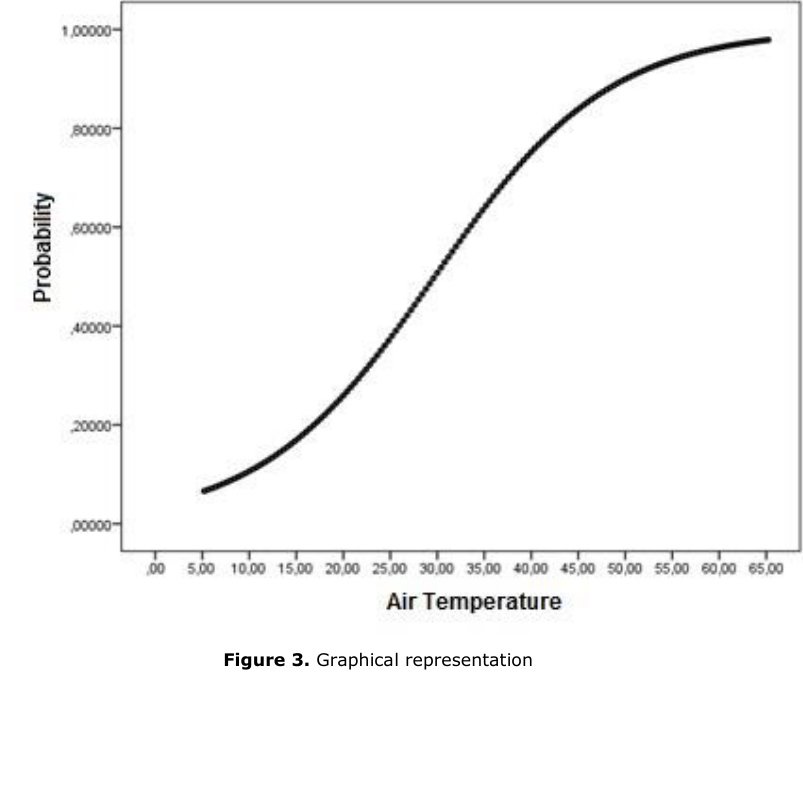
Figure 3. Graphical